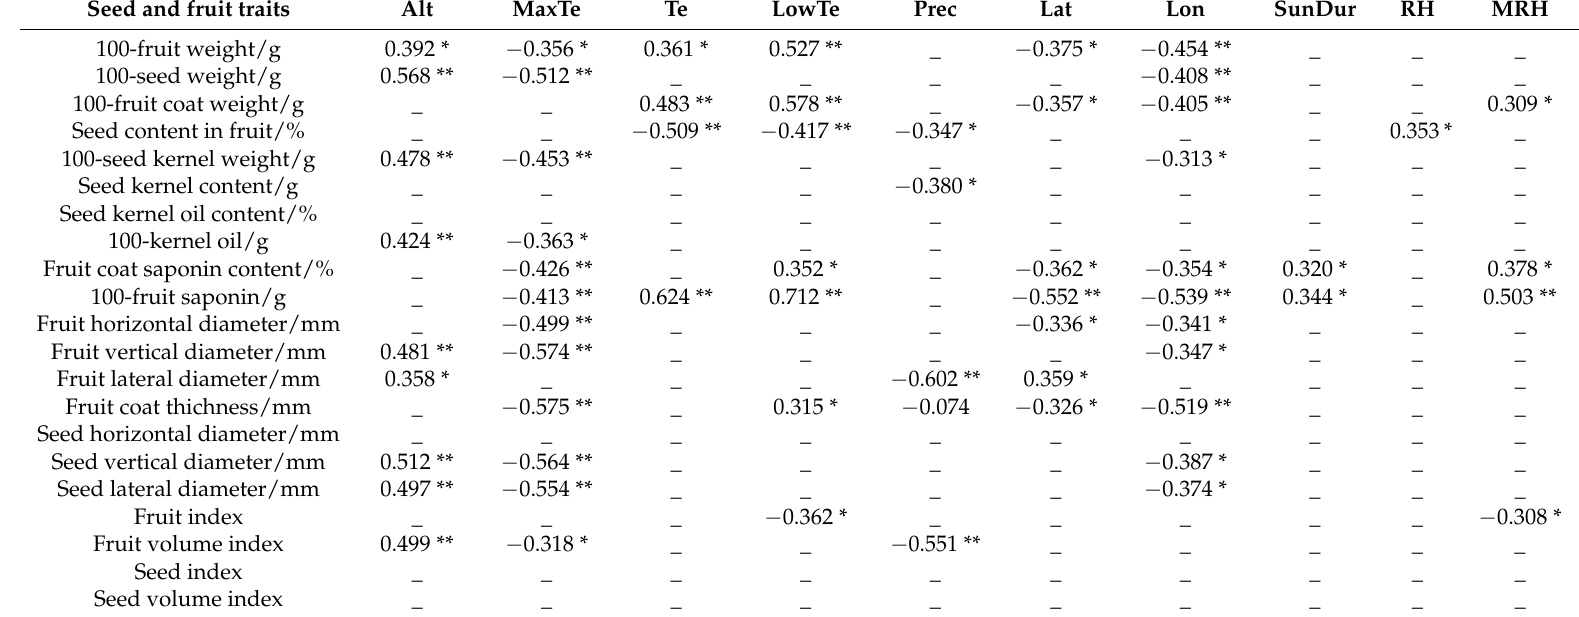
Table 3. Correlation analysis results between environmental factors, and seed and fruit traits of Sapindus mukorossi . Seed and fruit traits Alt MaxTe Te LowTe Prec Lat Lon SunDur RH MRH 100-fruit weight/g 0.392 * − 0.356 * 0.361 * 0.527 ** 100-seed weight/g 100-fruit coat weight/g Seed content in fruit/% 100-seed kernel weight/g Seed kernel content/g _ _ _ _ − 0.380 * Seed kernel oil content/% 100-kernel oil/g _ _ Fruit coat saponin content/% _ − 0.426 ** 0.352 * 0.378 * 100-fruit saponin/g _ − 0.413 ** Fruit horizontal diameter/mm _ − 0.499 ** Fruit vertical diameter/mm 0.481 ** Fruit lateral diameter/mm 0.358 * Fruit coat